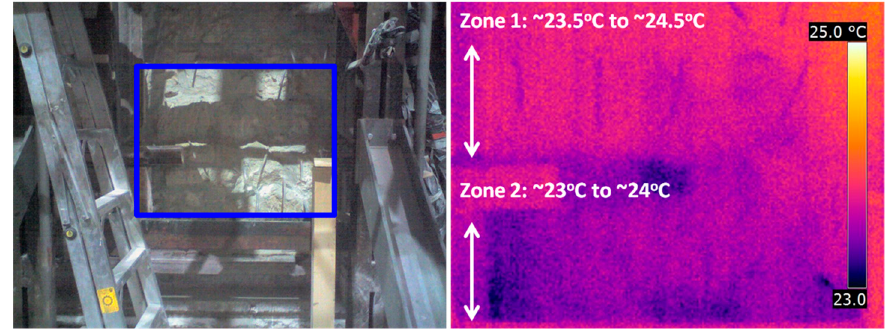
Figure 38. Panel N2 after repointing with installed grout injection tubes and corresponding IRT image.